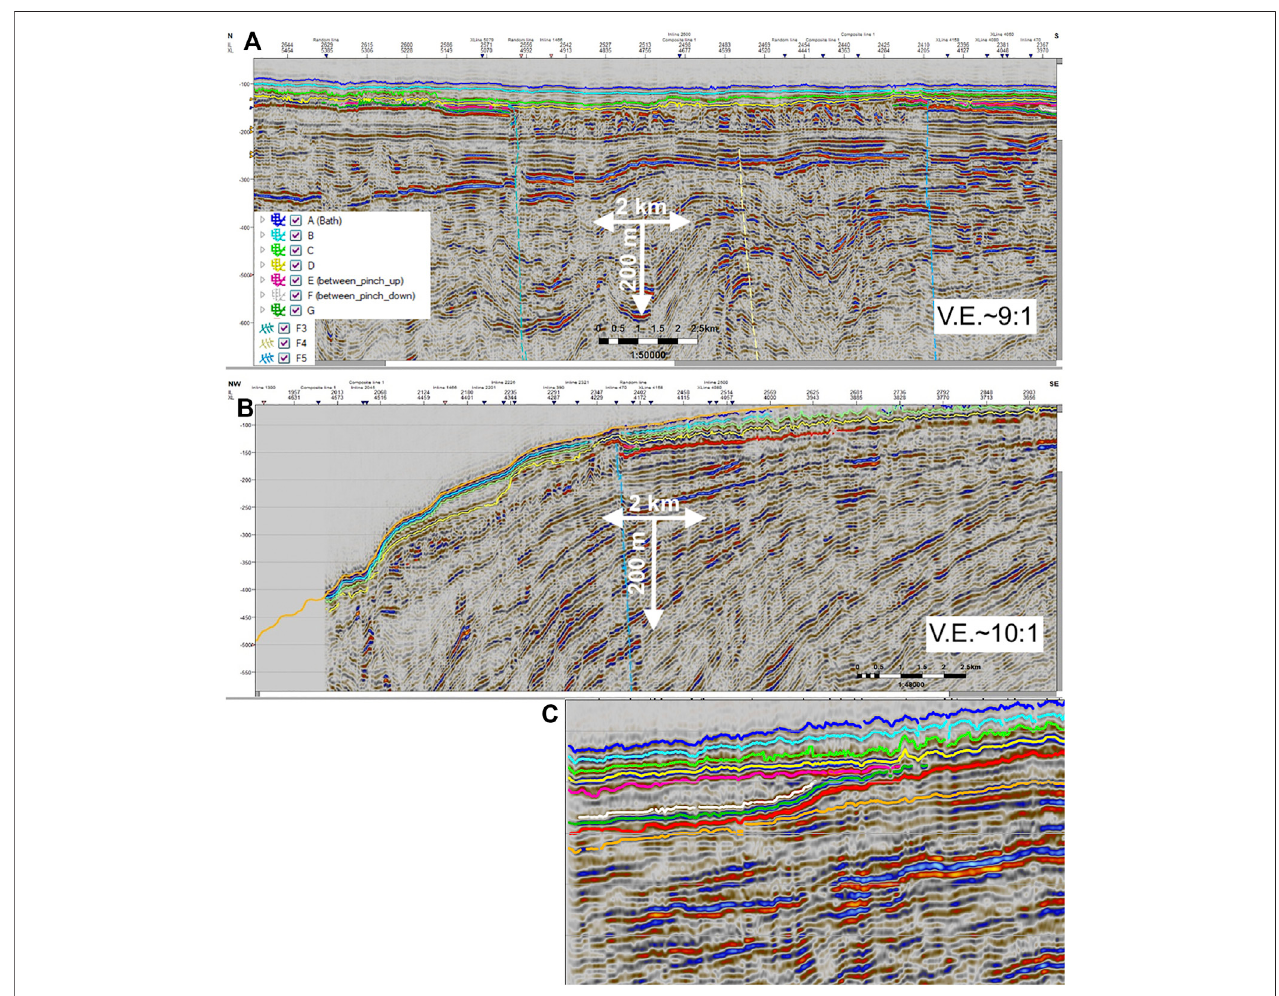
FIGURE 3 | Cross sections (A) North-South Section Parallel to Shoreline; (B) NW-SE section at the southern edge of the inner slide; (C) Pinchout point, in NW-SE cross section.